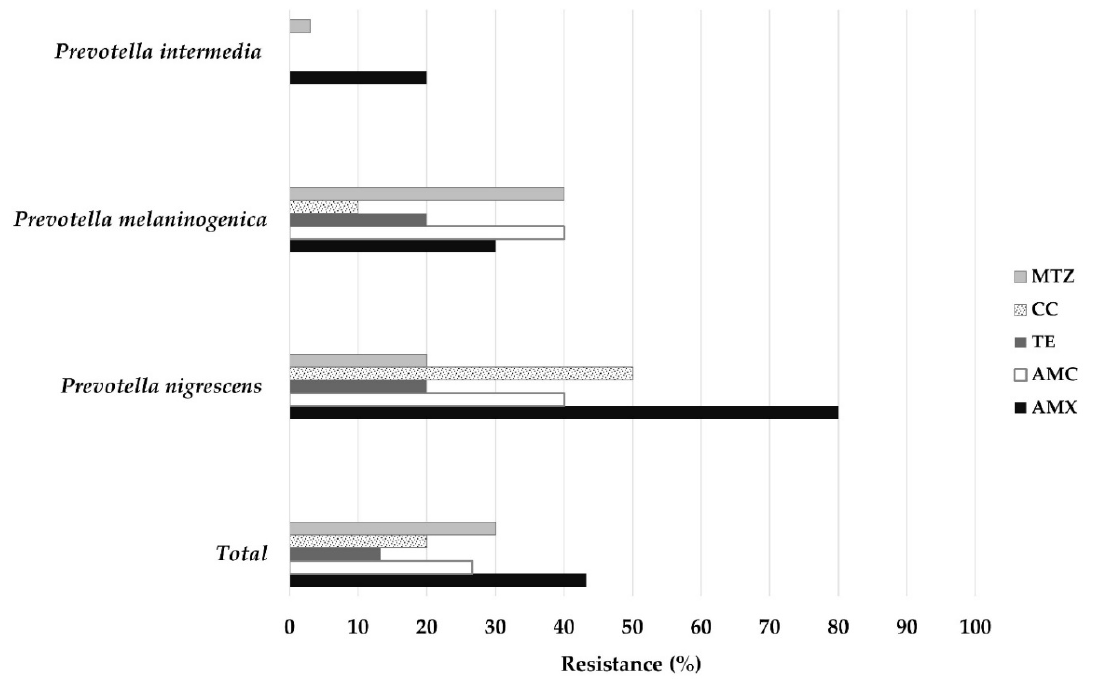
Figure 1. Frequency of resistance of Prevotella nigrescens, P. intermedia , and P. melaninogenica to the antibiotics evaluated.